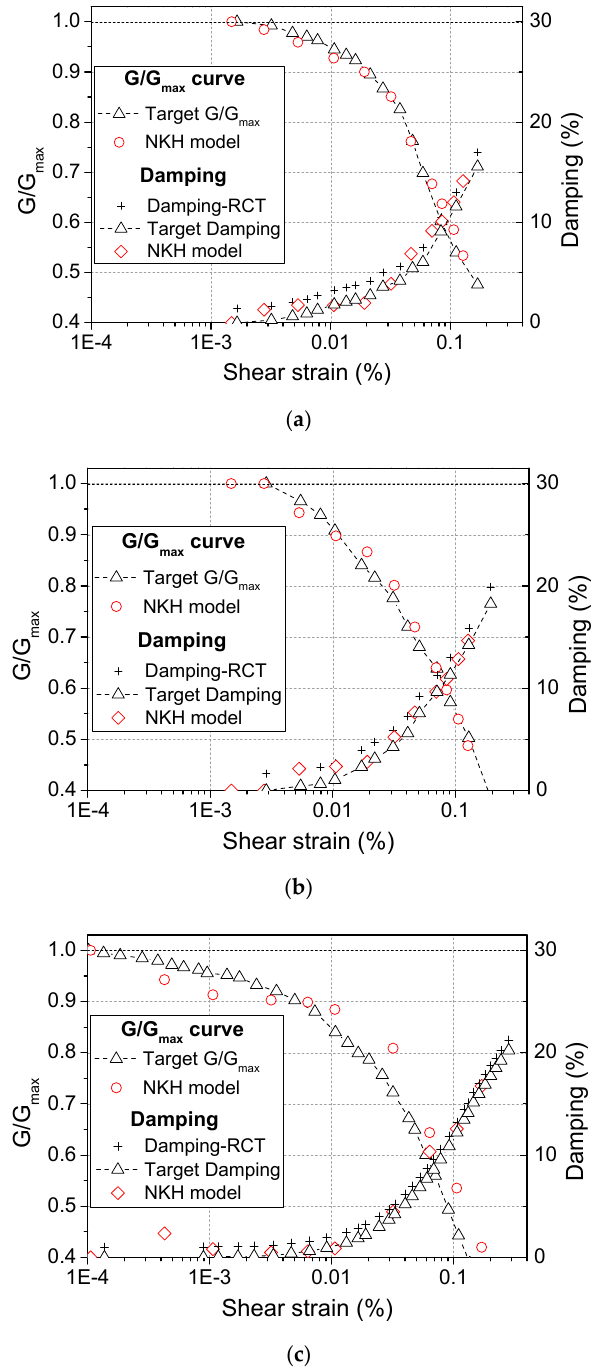
Figure 10. G/G max and damping curves with parameters of the NKH model (weighting factor, w = 0.95) for ( a ) silica sand, ( b ) mixture soil, and ( c ) Toyoura sand.